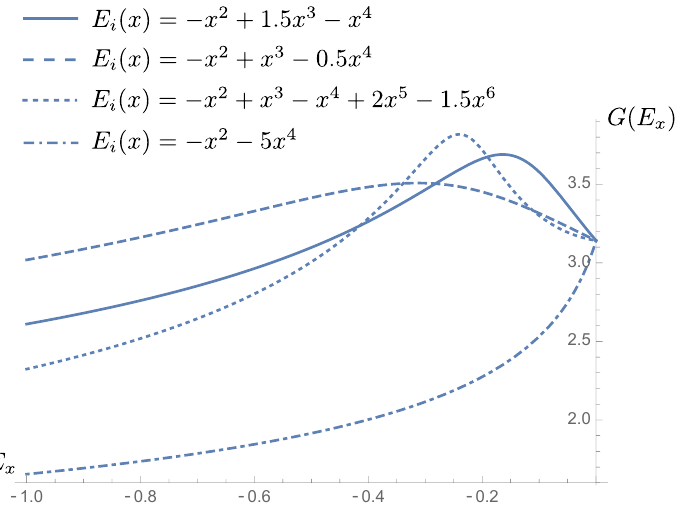
Figure 2. Behavior of the factor G ( E x ) for different potential barriers E i ( x ) with max ( E i ) = 0. Notice how, as E x → max ( E i ) , G ( E x ) tends to the finite expected value of π √